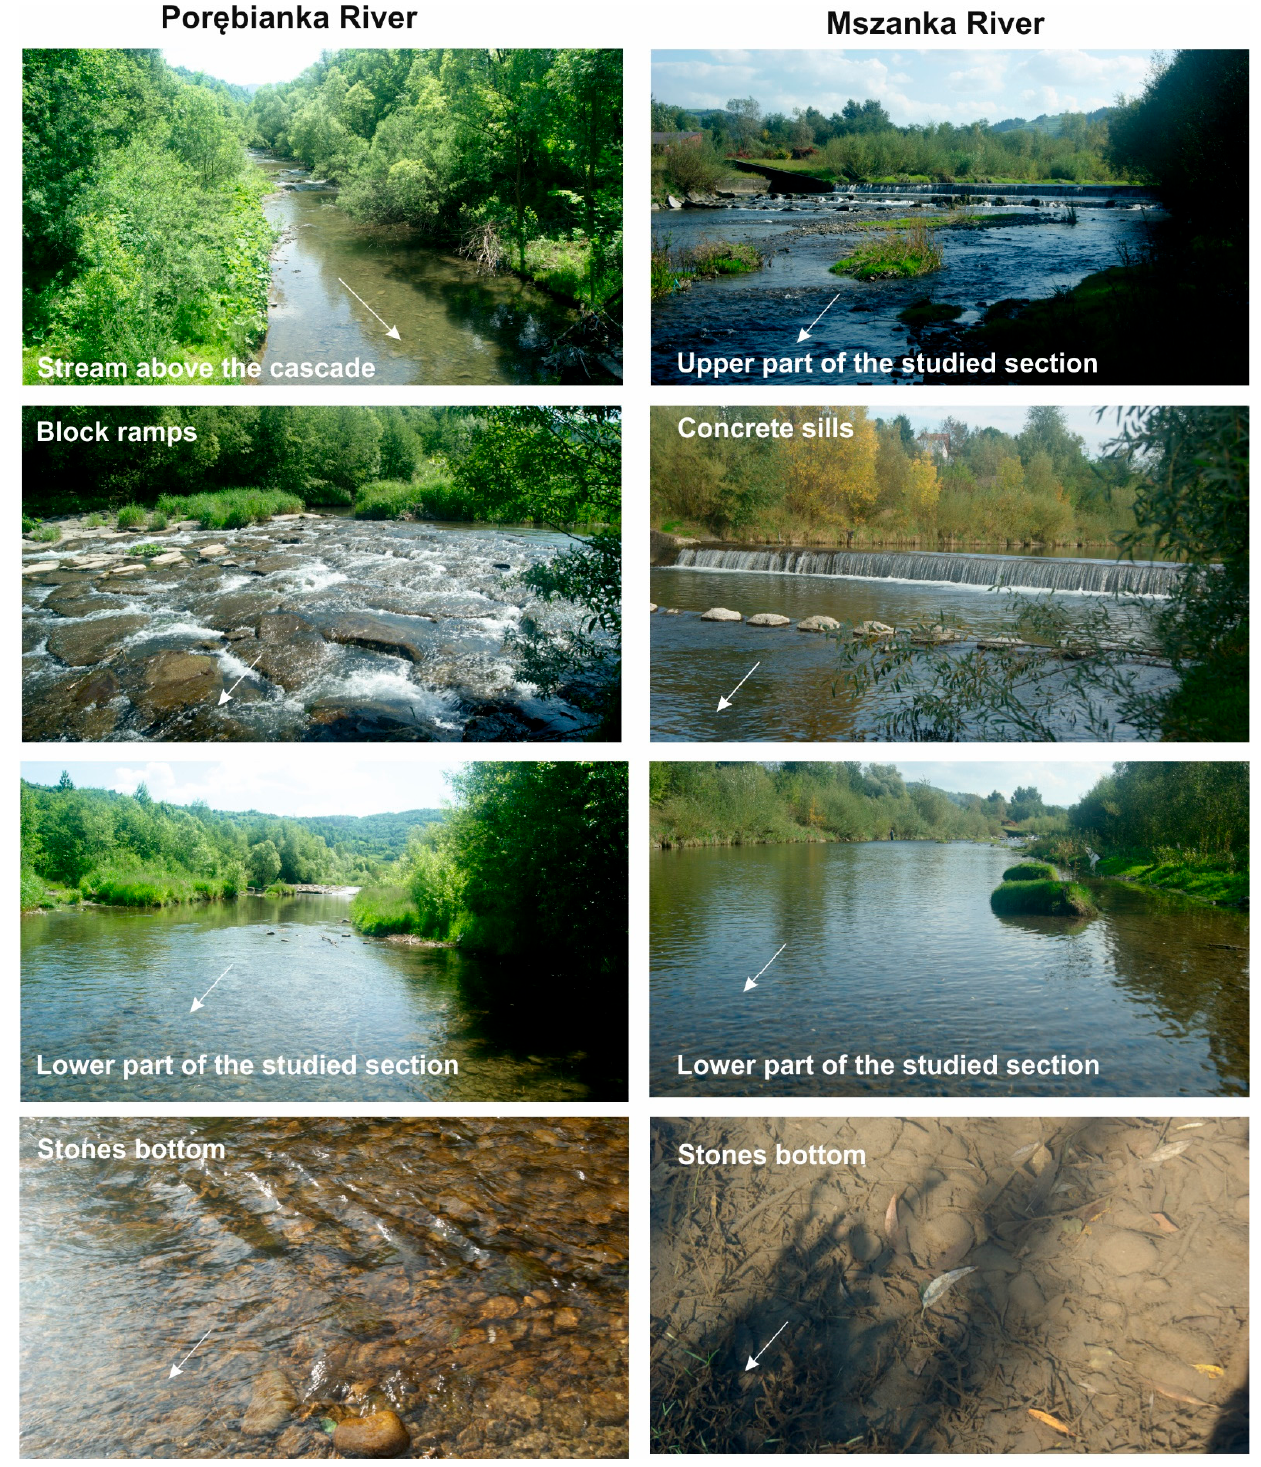
Figure 2. Characteristic features of the investigated sections of the Por ę bianka and Mszanka rivers; arrows indicate flow direction.